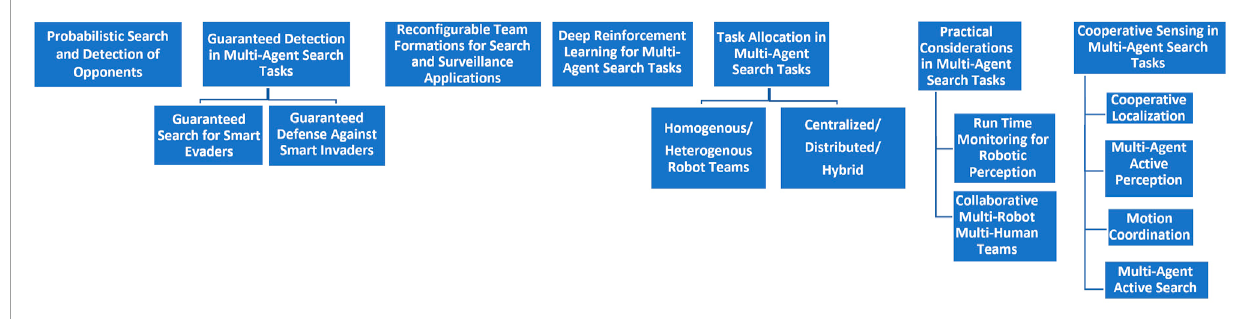
FIGURE 1 Classification of future research directions in multi-agent search